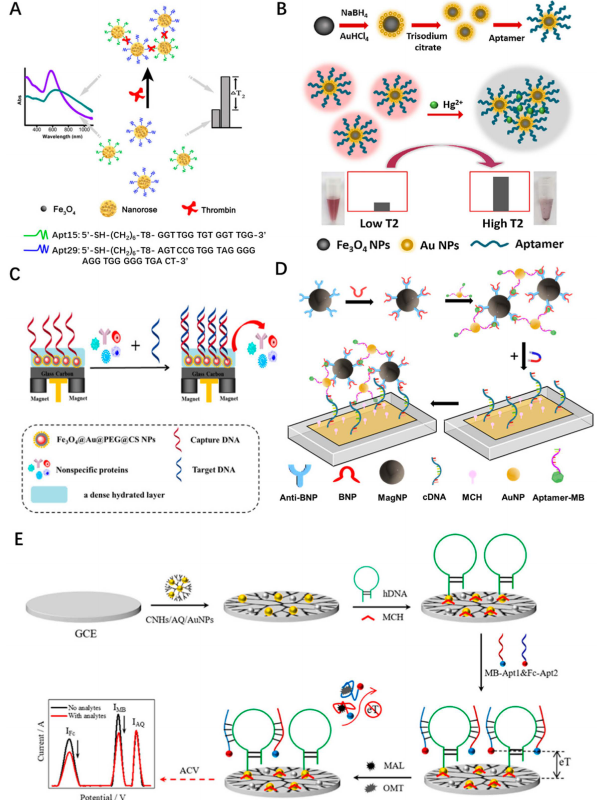
Figure 6. Aptamer capture assay methods. ( A ) Aptamer-linked sandwich assay for thrombin detec- tion using Fe 3 O 4 @Au nanoparticles, reproduced with permission from [71]. Copyright 2011 Analytica Chimica Acta. ( B ) The dual-mode sensor for Hg 2+ detection based on MRSw and colorimetric sensing, reproduced with permission from [72]. Copyright 2020 Journal of Hazardous Materials. ( C ) The low fouling electrochemical biosensor for Mycoplasma ovipneumoniae detection, reproduced